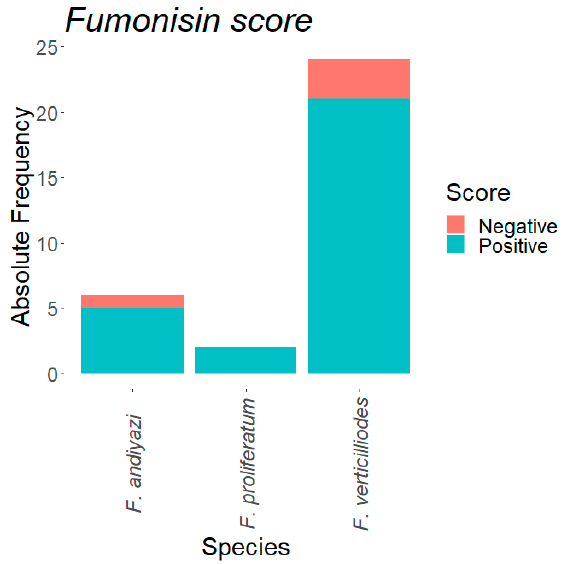
Microorganisms 2021 , 9 , x FOR PEER REVIEW Figure 3. Fumonisins production capabilities among Fusarium species isolated from northern Uganda.